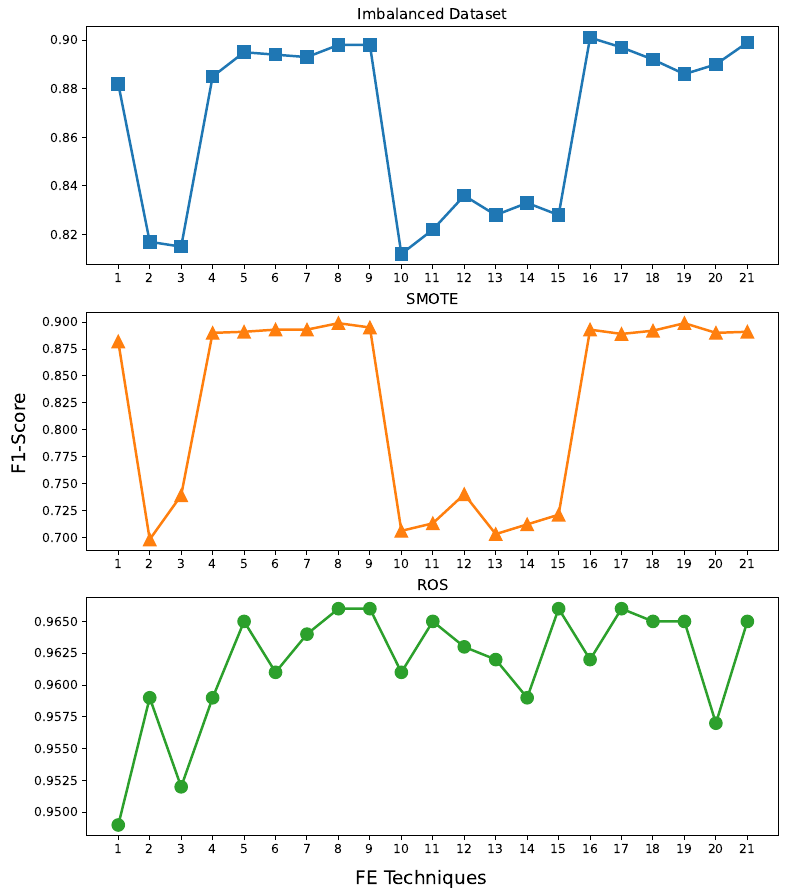
Figure 7. F1-score comparison with different FE techniques on imbalanced and oversampled data. Finally, the confusion matrix for the model on ROS oversampled data (see Figure 8c) displays better and more accurate results in identifying all classes, resulting in high true positive rates ([94, 100%]) for Negative-related, Positive, and Unrelated sentiments.